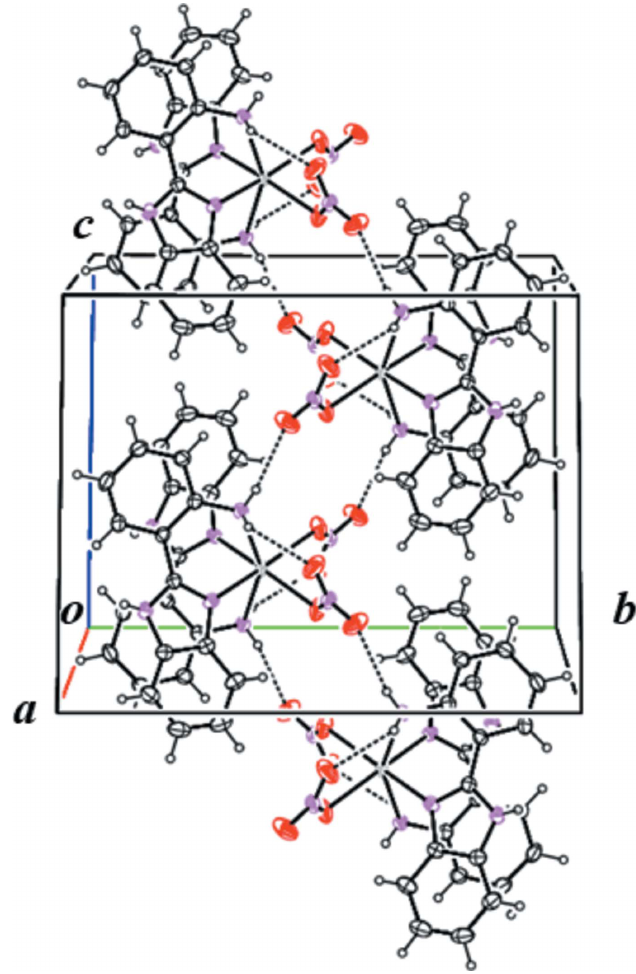
Figure 1 Figure 2 Molecular structure of the title compound, showing the atom-numbering scheme and displacement ellipsoids drawn at the 30% probability level. Partial packing diagram of the title compound, showing molecules linked The intramolecular N—H (cid:2)(cid:2)(cid:2) O hydrogen bonds are indicated by dashed lines. [Symmetry code: (i) (cid:5) x + 1, y , (cid:5) z + 3 2